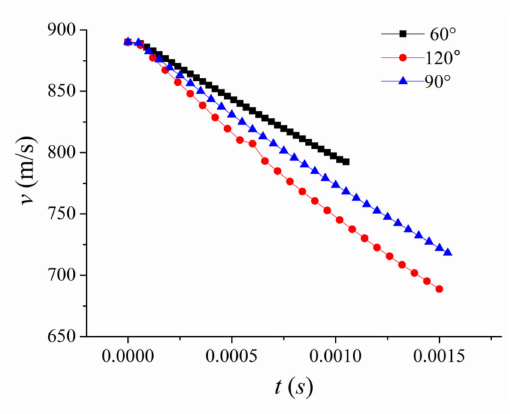
Figure 15. Velocity attenuation with di ff erent α .